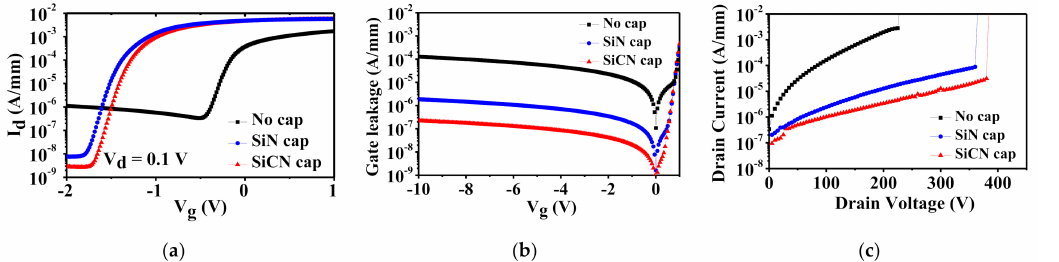
Figure 2. ( a ) I d − V g curves at V d = 0.1 V and ( b ) I g − V g curves for all fabricated AlGaN/GaN HEMTs with and without cap layer. ( c ) Off-state breakdown voltage (V br ) characteristics of measured devices with different kinds of cap layer at L gd = 5 µ